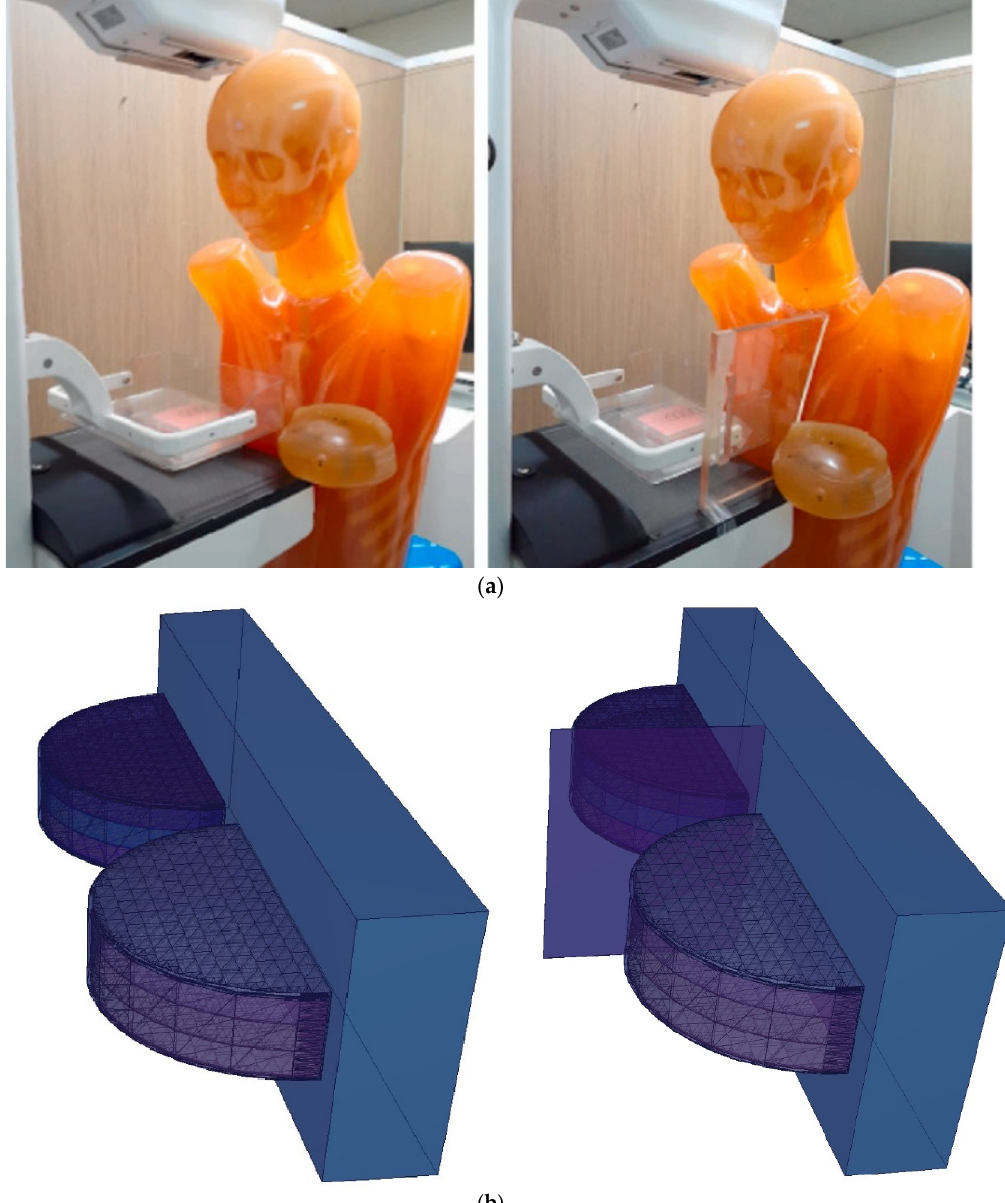
Figure 7. ( a ) Designed clinical setup for assessment of radio protectivity through lead-acrylic shield- ing screen by Koo and Lee [17]. ( b ) Designed MCNPX breast phantom using same parameters as clinical setup.